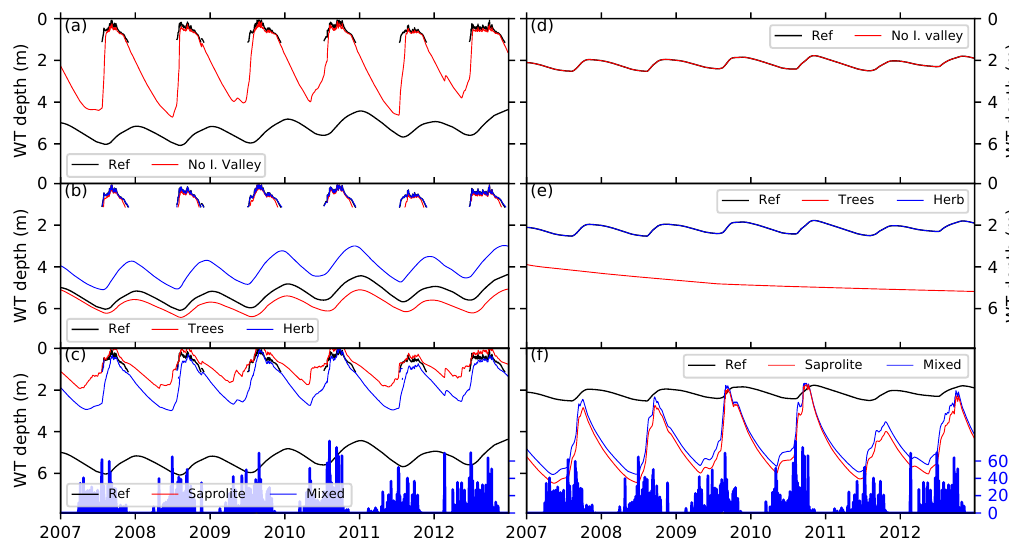
Figure 10. Simulated water table in the valley thalweg (a, b, c) at P1 and in the upper contributive area (d, e, f) at P2.